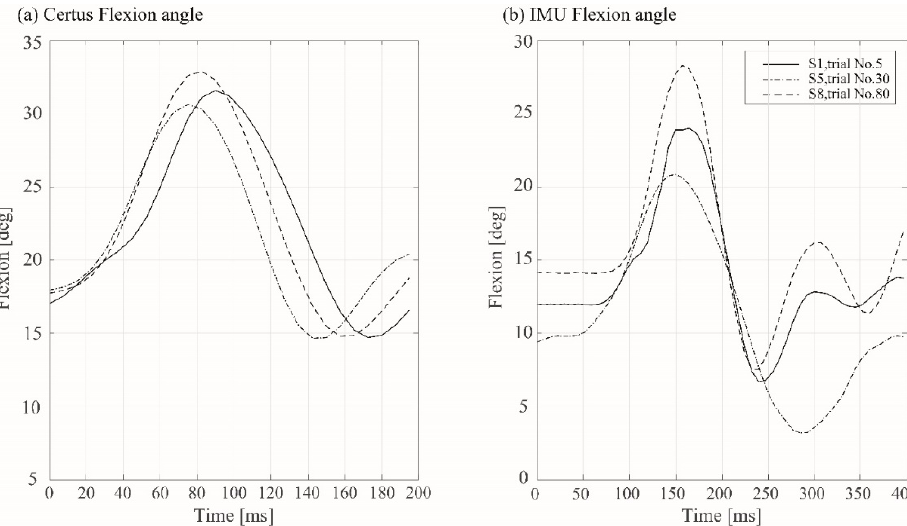
Figure 2. Three examples of the time course of the changes in knee flexion angle during simulated jump landings. Panel ( a ) shows measurements from the optoelectronic motion capture system, whereas panel ( b ) shows the calculated angles from the accelerometer and gyroscopic data from the IMUs. The peak angle change from the IMUs was calculated as the difference between the initial resting state and the maximum angle measured.